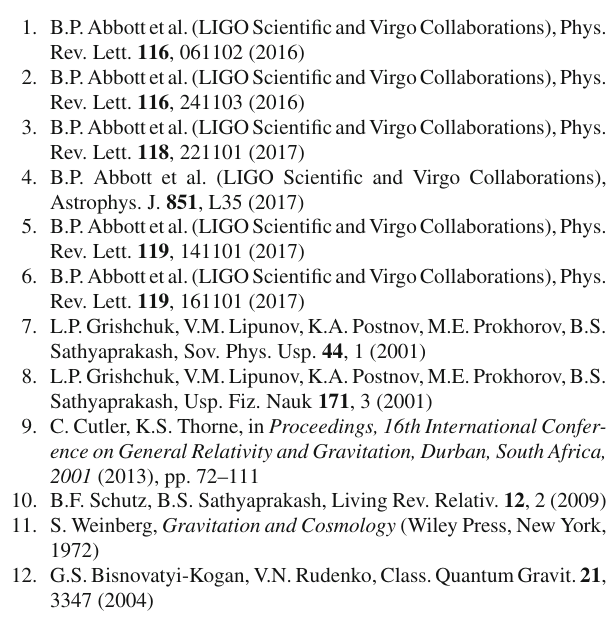
calculations which have been done in the case of hydrogen atoms, we find a spectrum whose shape is similar to that of the hydrogen atoms but the signal is much stronger. Here, the dominant contribution comes from the 3 d − 1 s transi- tion of He + at the redshift z ∼ 6000, which gives a peak in frequency at ω = 1 . 22 × 10 13 Hz, and the relative energy than that from hydrogen atoms. This significant